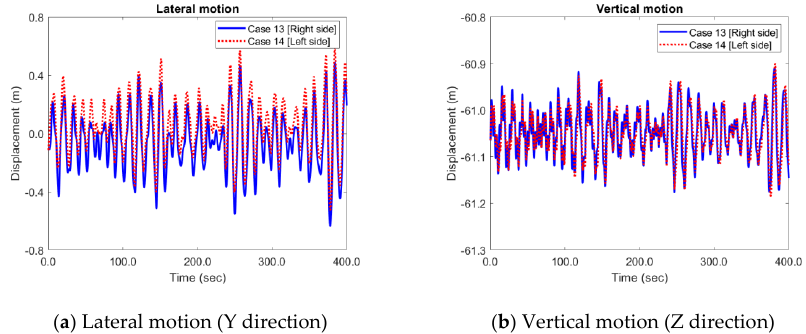
Figure 7. Time histories of lateral and vertical displacements of the tunnel at its mid-length (numerical sensor No. 5) in two different mooring-failures in the opposite sides.